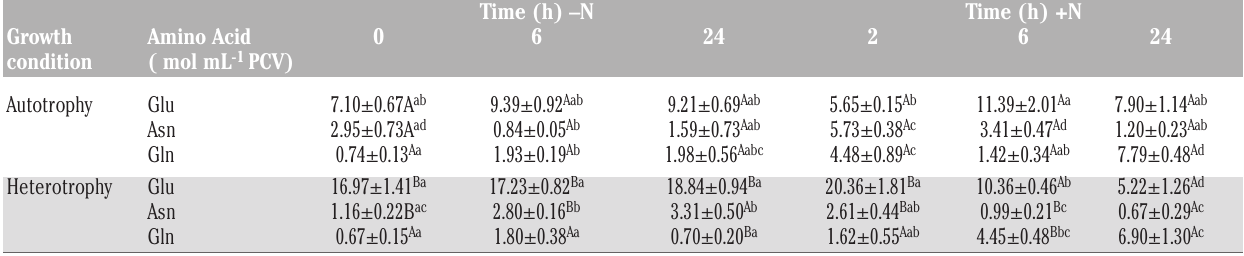
The superscript letters indicate the statistical significance, identical letters identify means that are not significantly different; different letters identify statistically different means (P < 0.05). Upper case letters indi- cate the comparison between autotrophic and heterotrophic